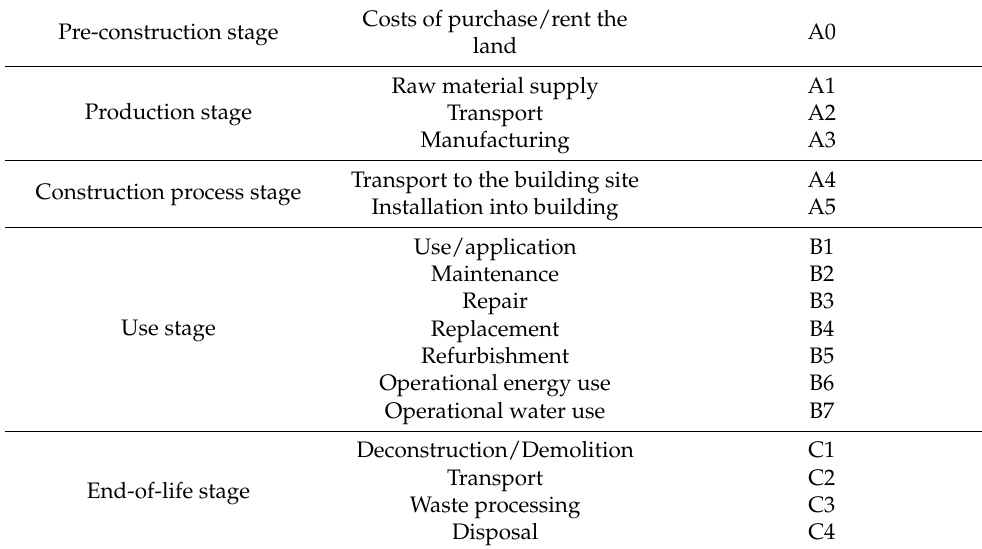
Table 1. LCC modules according to EN 16627